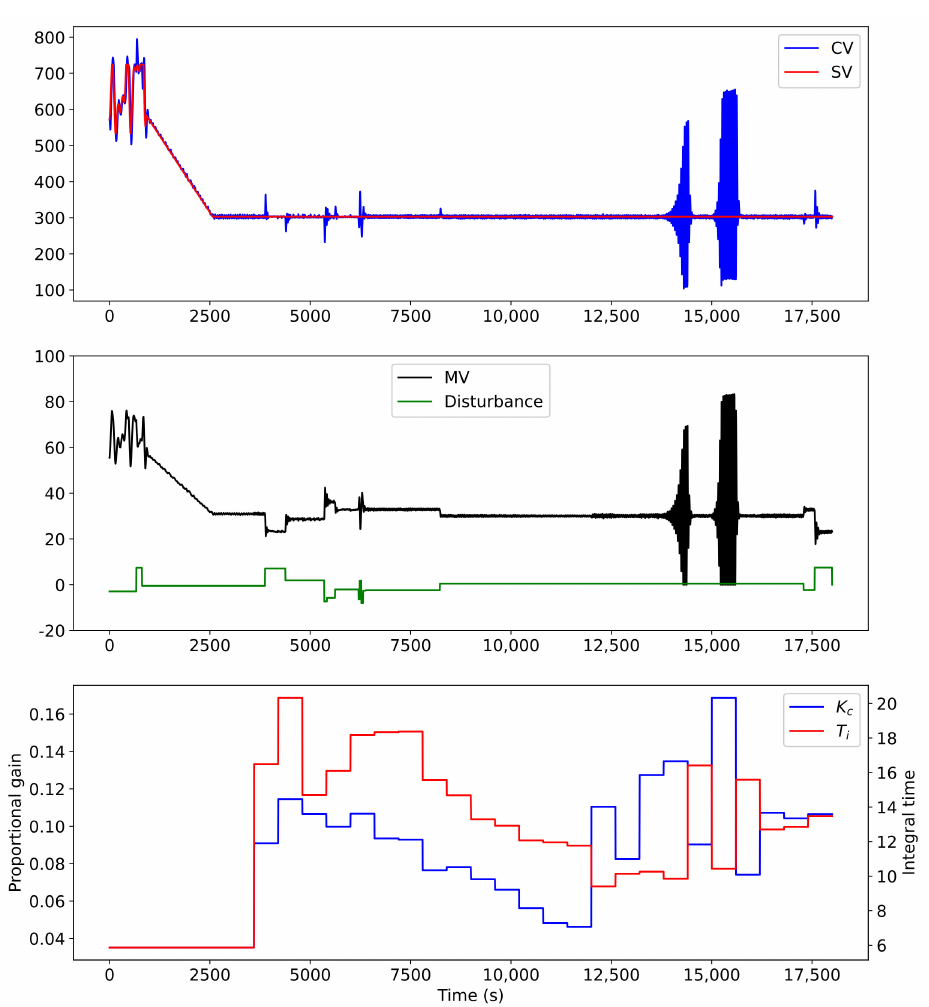
Figure 3. Example of poor performance as a result of selecting too high a proportional gain. ( Top ): the controlled variable and set point variable. ( Middle ): the manipulated variable and input disturbance. ( Bottom ): the controller gains selected by the